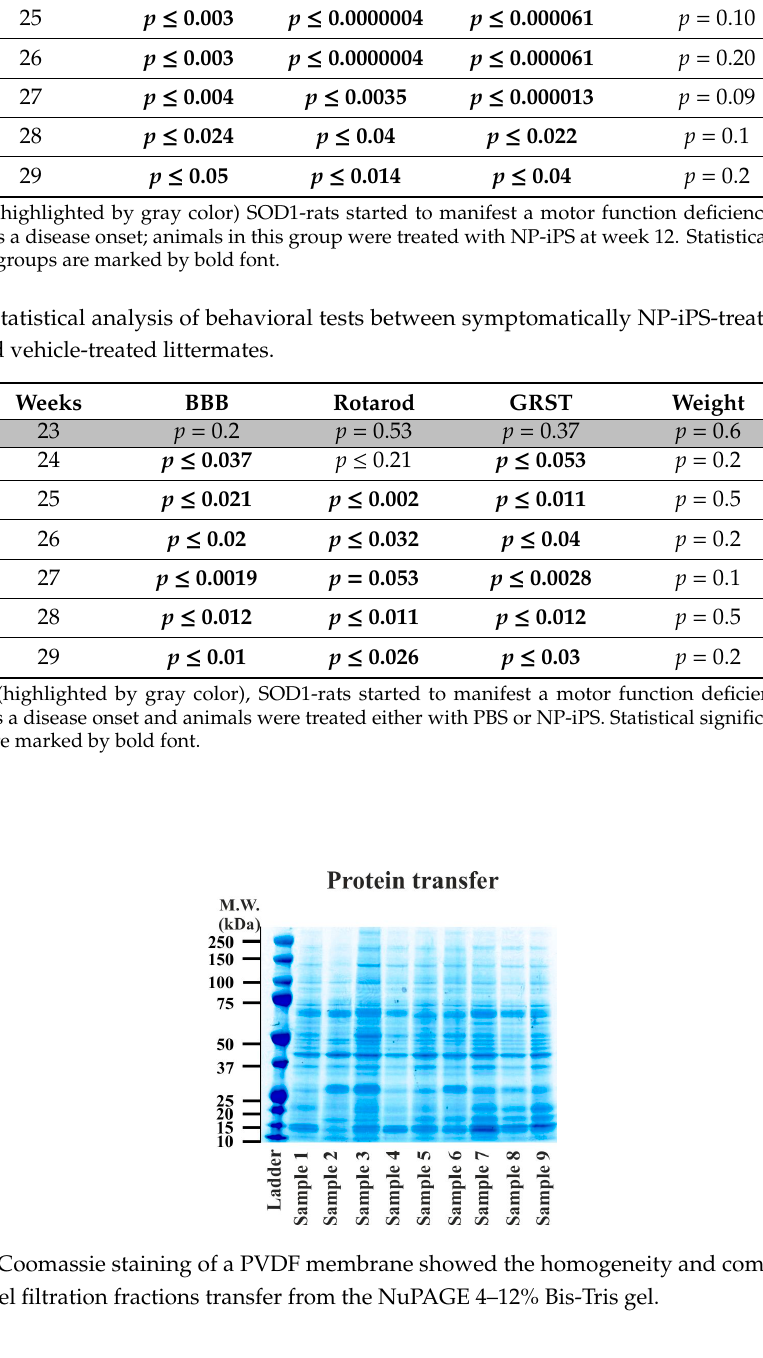
Table A1. Statistical analysis of behavioral tests between asymptomatically NP-iPS-treated group of animals and vehicle-treated littermates.